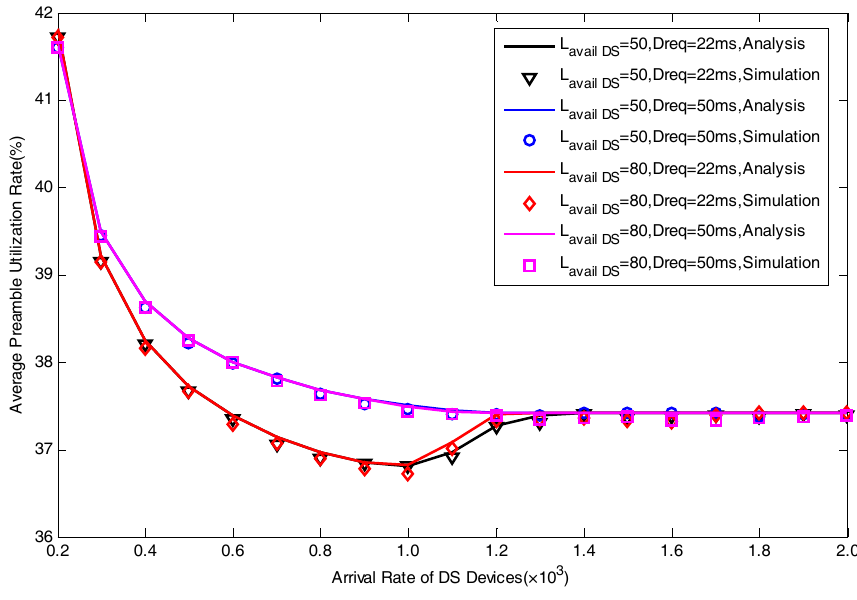
Figure 8. Average Preamble Utilization Rate with different L avail _ DS and D req .